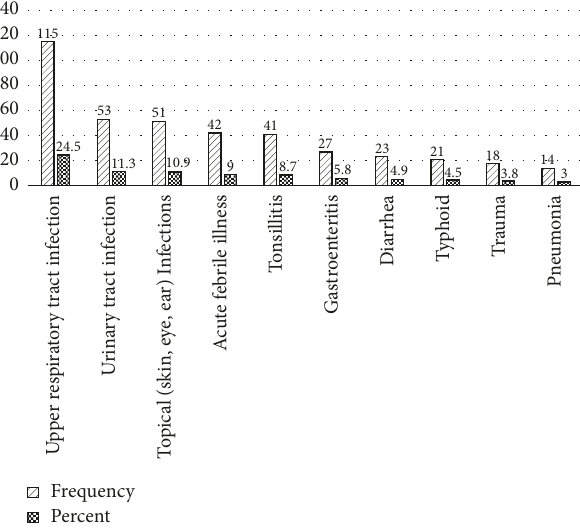
Figure 2: Top 10 disease conditions for which antibiotics were 31, 2016.